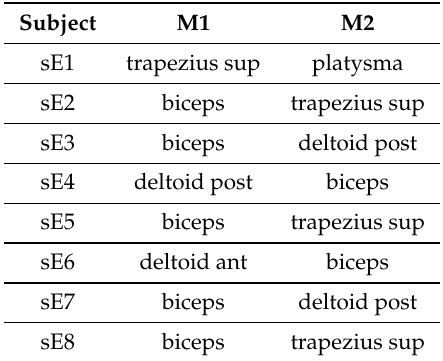
Figure 1. System diagram. The algorithms translate either EMG or IMU signals into commands for the robotic hand or the electrical stimulator. The robotic hand has three possible gestures: at-rest, open and close. The electrical stimulator can receive three commands: no stimulation, stimulate channel 1 (wrist flexion) or stimulate channel 2 (wrist extension). Users are able to observe the outcome of their input and use it as biofeedback. Table 3. Muscles chosen in EMG group. Muscle 1 (M1) contractions are associated with hand opening and muscle 2(M2) contractions are associated with hand